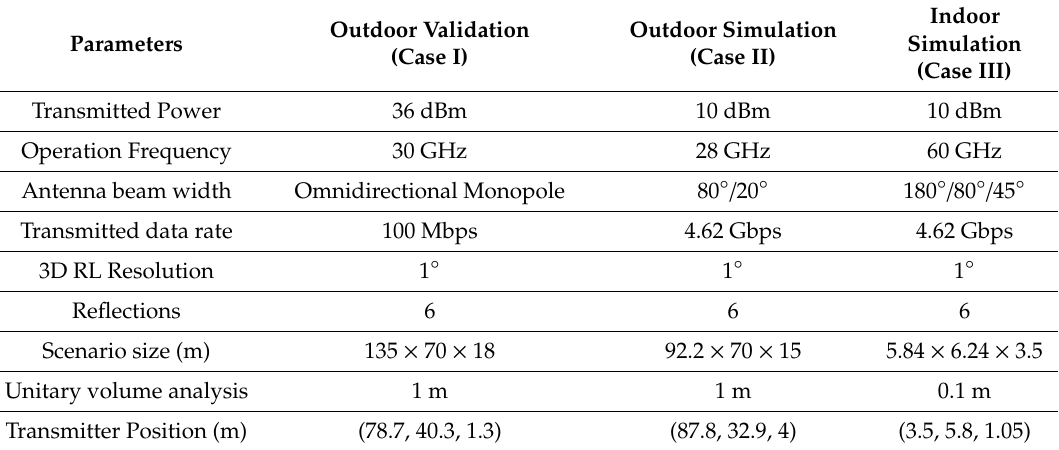
Table 2. Three-dimensional ray-launching simulation parameters.